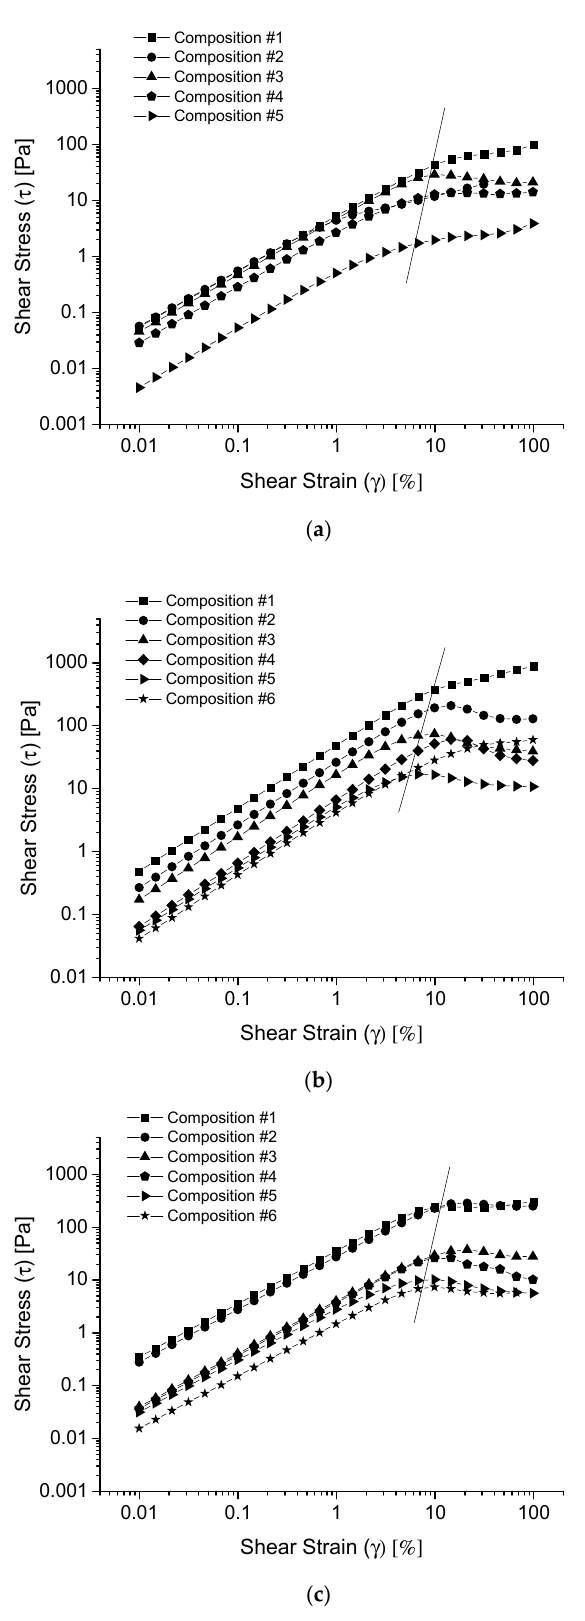
Figure 2. Shear stress ( τ ) versus shear strain ( γ ) curves (in logarithmic scales) for the given co-hydrogel systems prepared in water ( a ), phosphate-buffered saline (PBS) buffer ( b ), and glycine/NaOH buffer ( c ).